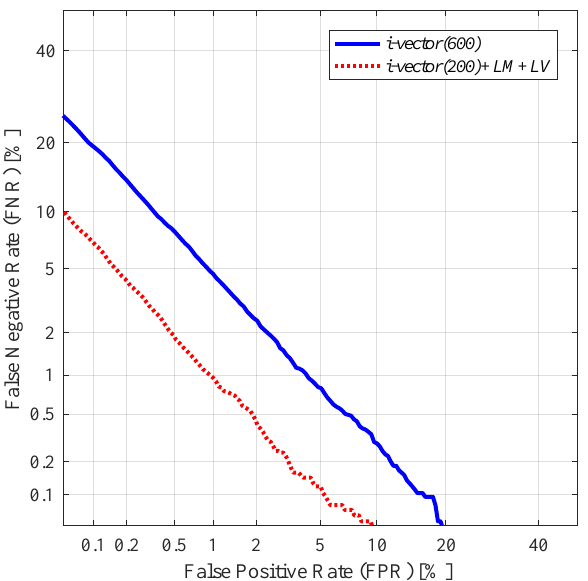
Figure 7. DET curves of the speaker verification experiments using 600-dimensional i-vector and combined feature of 200-dimensional i-vector, latent variable mean, and the log-variance of the latent